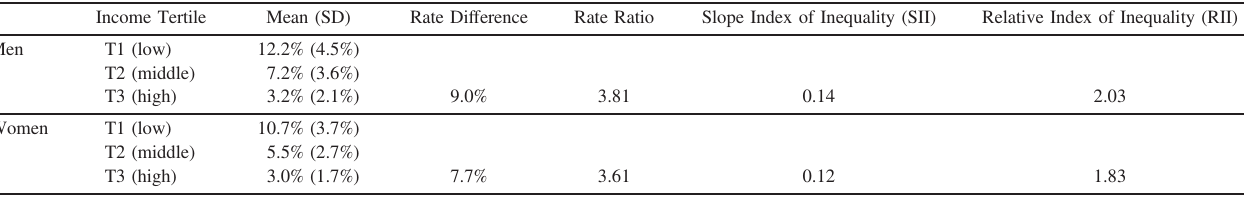
Table 1. Income-based inequality statistics and indices in depressive symptoms for older Japanese men ( n = 51,962) and women ( n = 52,958)